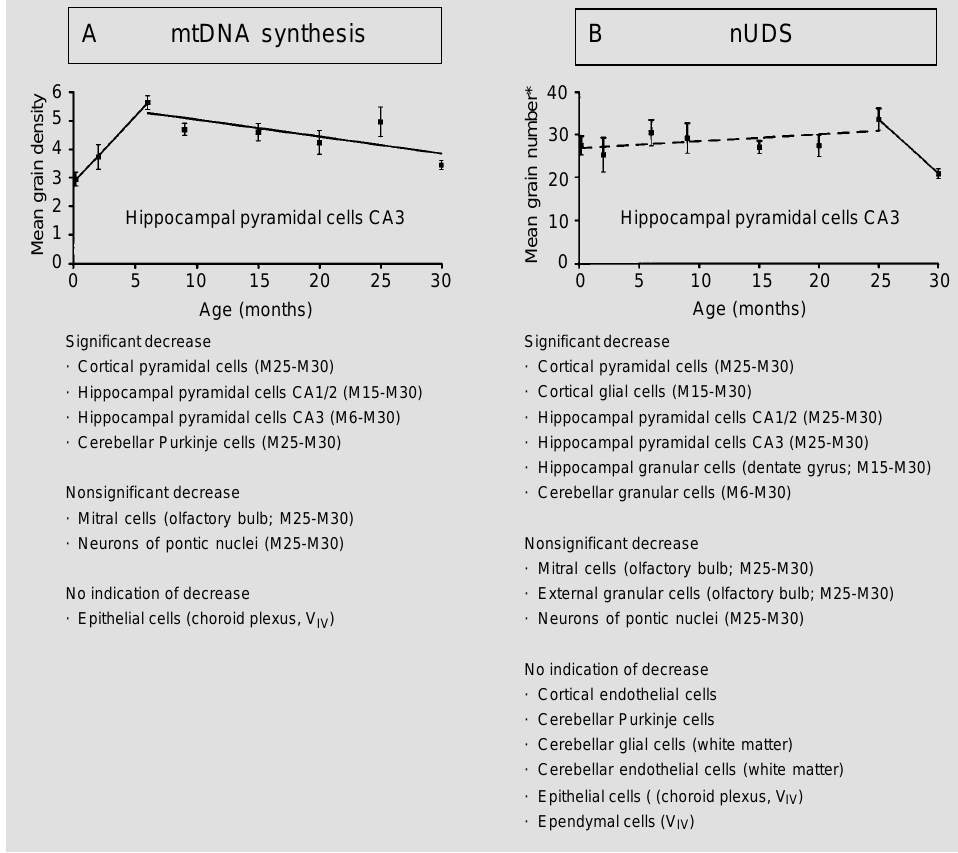
Figure 6 - Compilation of results concerning mtDNA synthesis (A) and unscheduled nuclear DNA synthesis (nUDS) (B) as a function of age of male NMRI mice. A, Mean grain densities ± SEM of the cytoplasm corrected for background and [ 3 H]-ß-self- absorption. B, Mean grain num- bers per nucleus* ± SEM, i.e., corrected and normalized with respect to relative DNA content (see text). Full lines represent regression lines with a slope sig- nificantly different from zero (P<0.05; broken line, nonsignifi- cant increase). M25, 25 months;